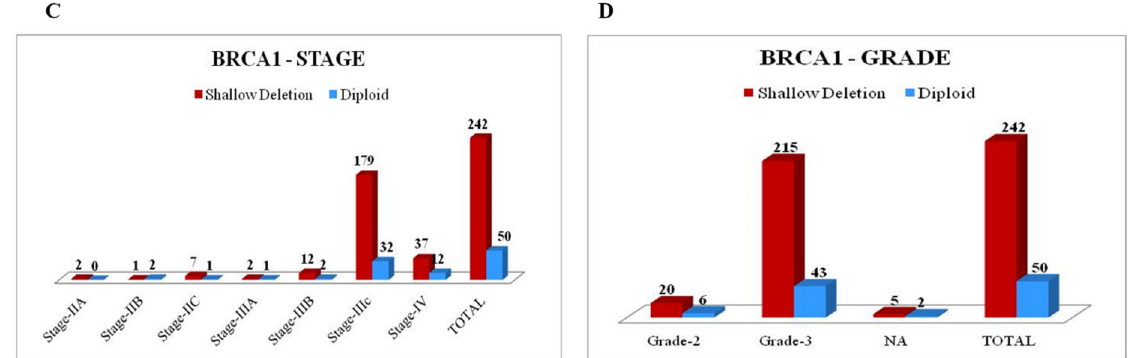
Figure 3. Shallow deletion of BECN1 and BRCA1 correlates with stage IIIC and grade 3 in ovarian cancers. ( A ) Graph representing the distribution of BECN1 copy number variation (CNV) according to tumor stage. ( B ) Graph representing the distribution of BECN1 CNV according to tumor grade. ( C ) Graph representing the distribution of BRCA1 CNV according to tumor stage. ( D ) Graph representing the distribution of BRCA1 CNV according to tumor grade.